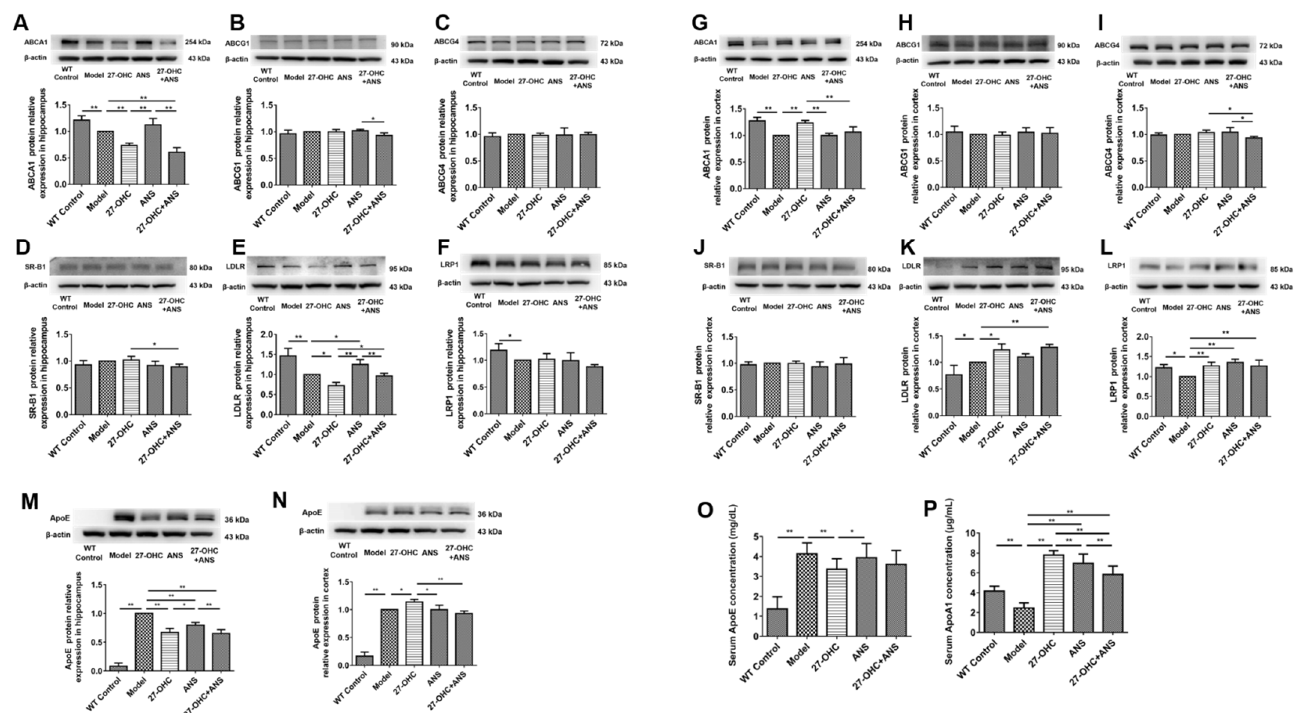
Figure 7. Expression of cholesterol transport-related proteins in the brain and serum: ( A – F ) the protein expression in the hippocampus—( A ) ABCA1 protein, ( B ) ABCG1 protein, ( C ) ABCG4 protein, ( D ) SR-B1 protein, ( E ) LDLR protein, and ( F ) LRP1 protein; ( G – L ) the protein expression in the cortex—( G ) ABCA1 protein, ( H ) ABCG1 protein, ( I ) ABCG4 protein, ( J ) SR-B1 protein, ( K ) LDLR protein, and ( L ) LRP1 protein; ( M ) ApoE protein expression in the hippocampus; ( N ) ApoE protein expression in the cortex; ( O ) Serum ApoE concentration; ( P ) Serum ApoA1 concentration; n = 5/group. Densitometric analyses were normalized to β -actin. All data are shown as mean ± SD. * p < 0.05; ** p < 0.01.